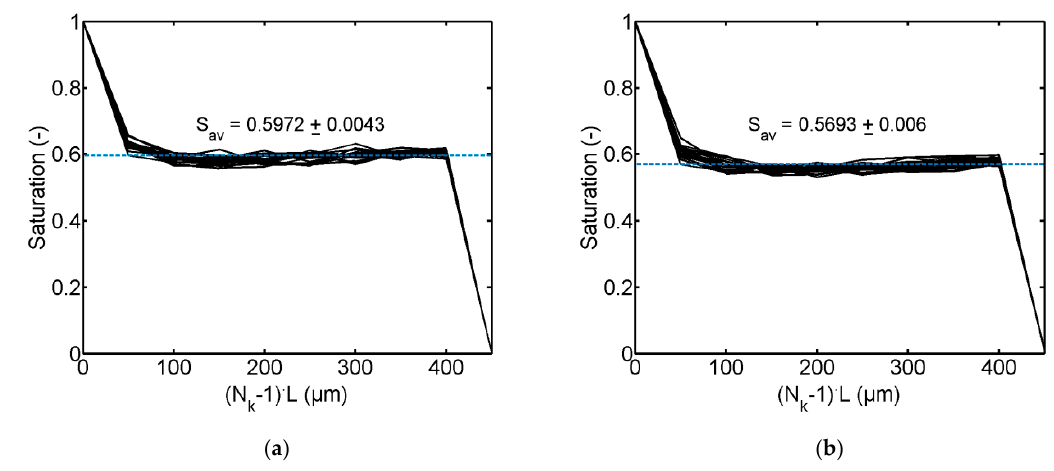
Figure 11. ( a ) Steady state saturation profiles of 20 PN realizations with standard deviation 0.5 µm. ( b ) Steady state saturation profiles of 20 PN realizations with standard deviation 1 µm.